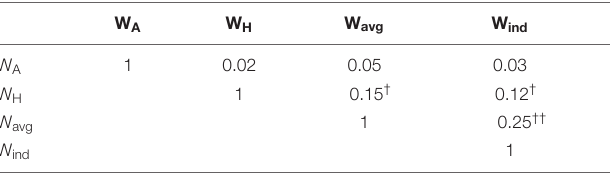
TABLE 2 | Correlation matrix showing the correlation coefficients of the phases of prefrontal theta oscillation in the signal resulting from the respective filters, averaged across all subjects (Kruskal-Wallis test, p < 0.0001; post-hoc [W A vs.